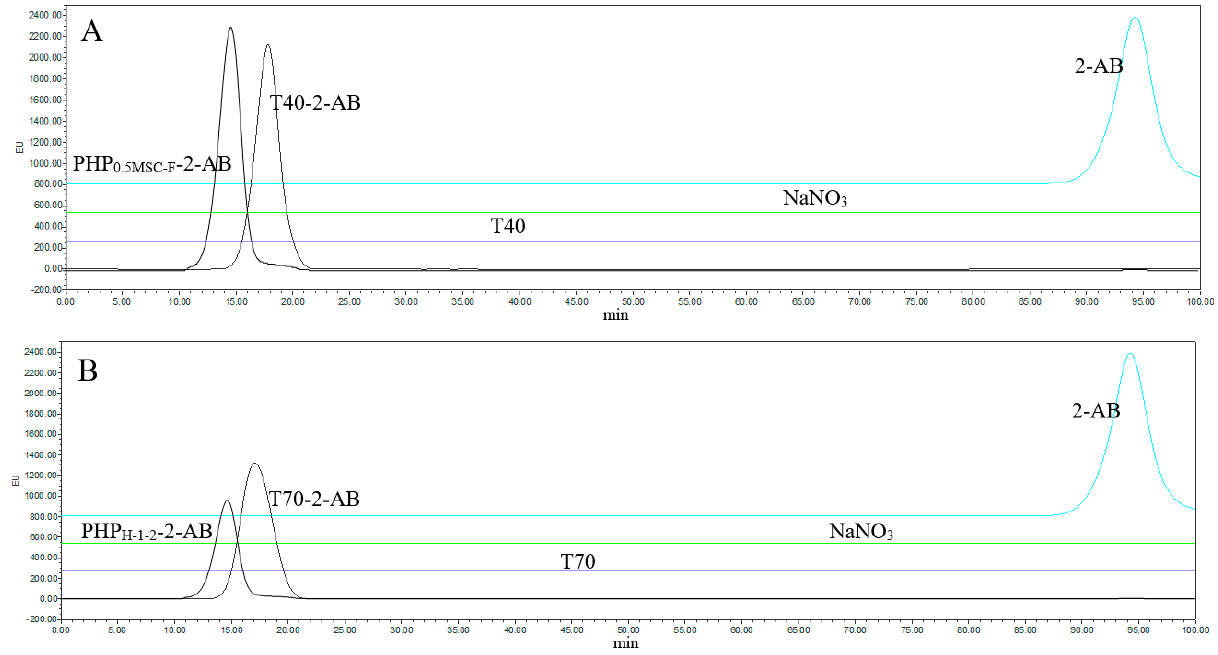
Figure 5. The HPLC chromatogram of dextran standards and polysaccharide samples with 2-AB fluorescence labeling: ( A ) PHP 0.5MSC-F -2-AB (240 µ g/mL); ( B ) PHP H-1-2 -2-AB (240 µ g/mL).